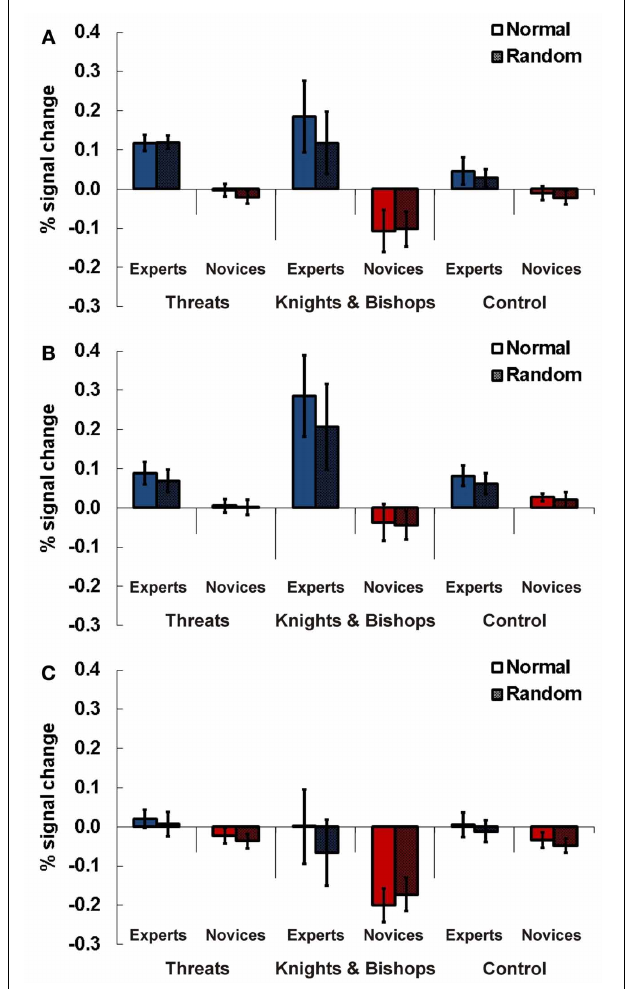
FIGURE 6 | Results Experiment 4. Percent signal change (PSC) for the three experimental conditions threats (indicated whether the number of threats of black to white was four), knights and bishops (indicate whether the number of knights and bishops of both colors was four), and control (non-chess control task, all pieces regardless of color or type were counted, indicate if the number is 15) for experts and novices in normal (chess pieces arranged according to real chess matches) and random (chess pieces in randomized distribution) chess arrays. Results are presented for TPJ ROI right (A) , left anterior (B) , and left posterior TPJ (C) . Error bars indicate standard error of the